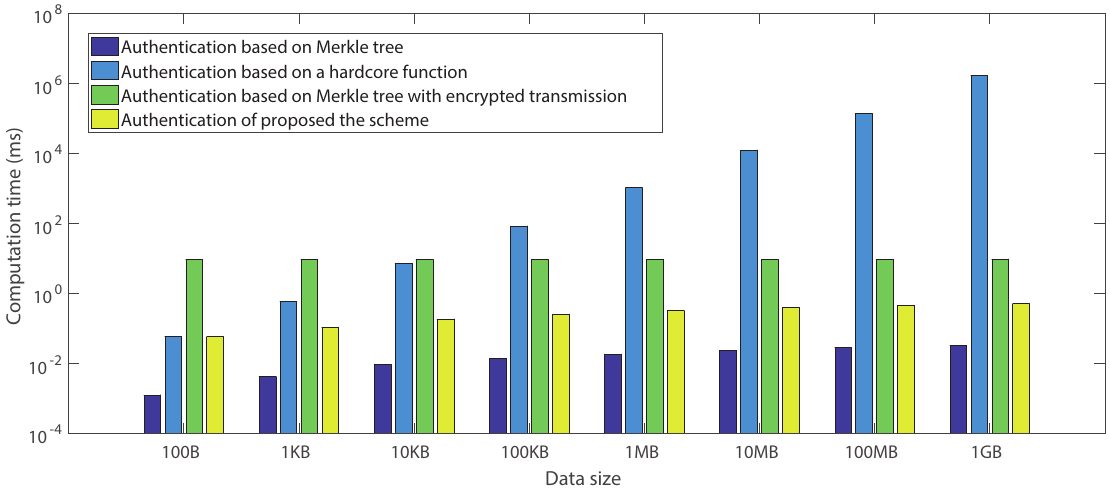
Figure 10. Comparison of computation overhead on the verifier